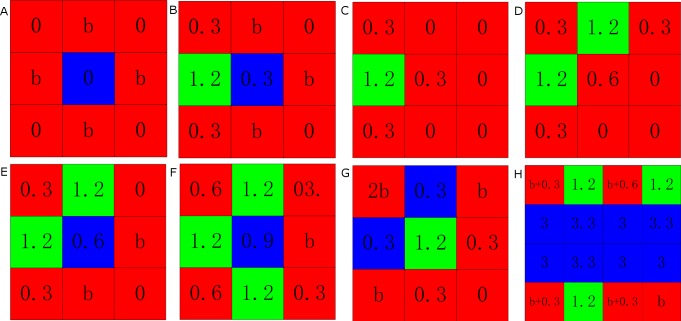
Special configurations of players.In all panels the cooperators are depicted blue while defectors are depicted red and loners are depicted green. Each small square corresponds to a single player. Denoted values correspond to the payoffs of individual players, as obtained for the presented configurations.